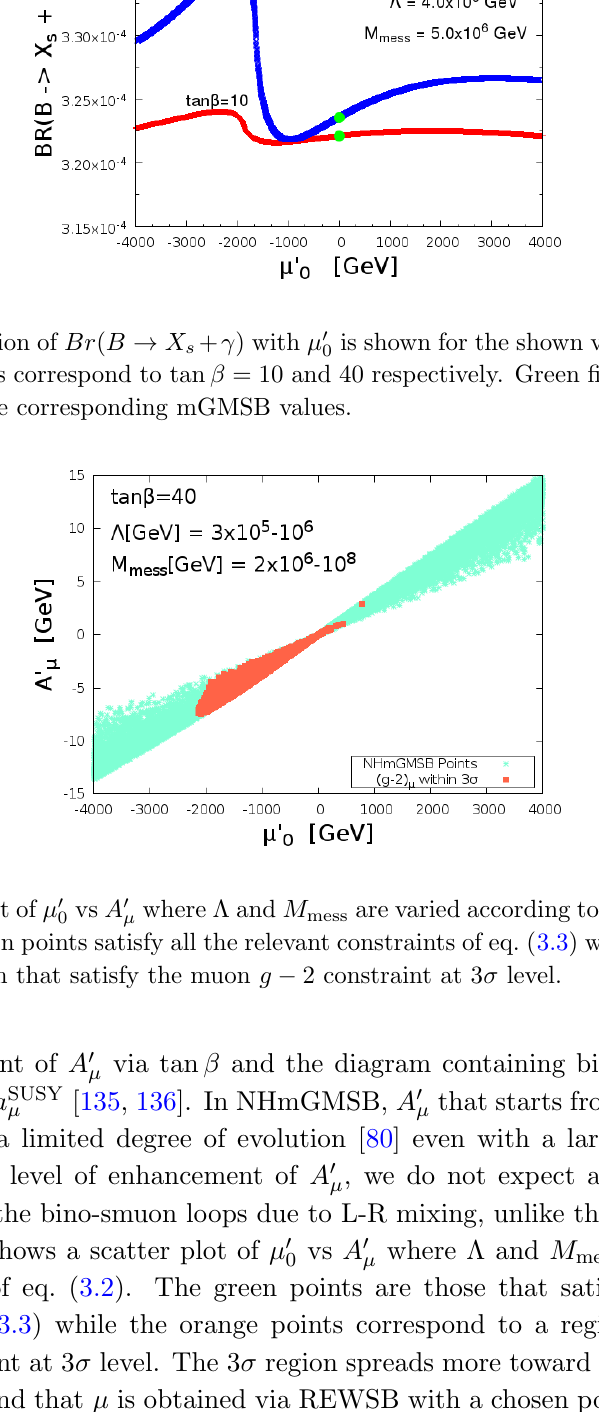
is shown for the shown values of (cid:3) and M mess . 0